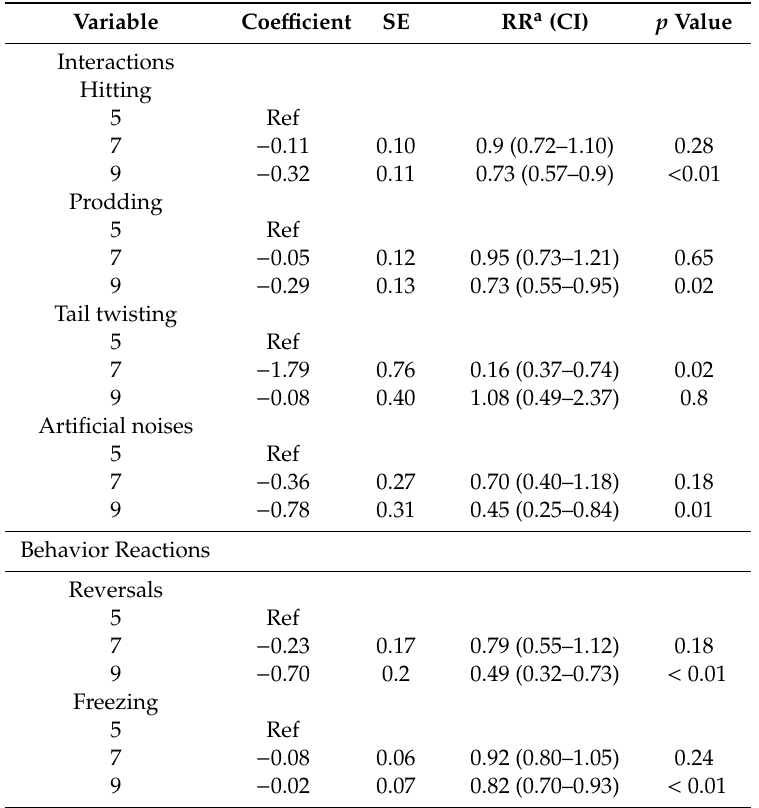
Table 5. E ff ect of the time of handling within a workday (5:00, 7:00 and 9:00 h) on total livestock handlers’ interactions and total cattle behavior reactions during handling at livestock market. The duration of the handling being evaluated was included as a covariate in the analysis. The model was P ( k events in interval ) = e − λ λ k , where λ is the average number of events per interval, e is the k ! Euler’s number, κ takes values o, 1, 2.., κ ! = κ × ( κ − 1) × ( κ − 2) × ... × 2 × 1 is the factorial of κ . Variable Coe ffi cient SE RR a (CI) p